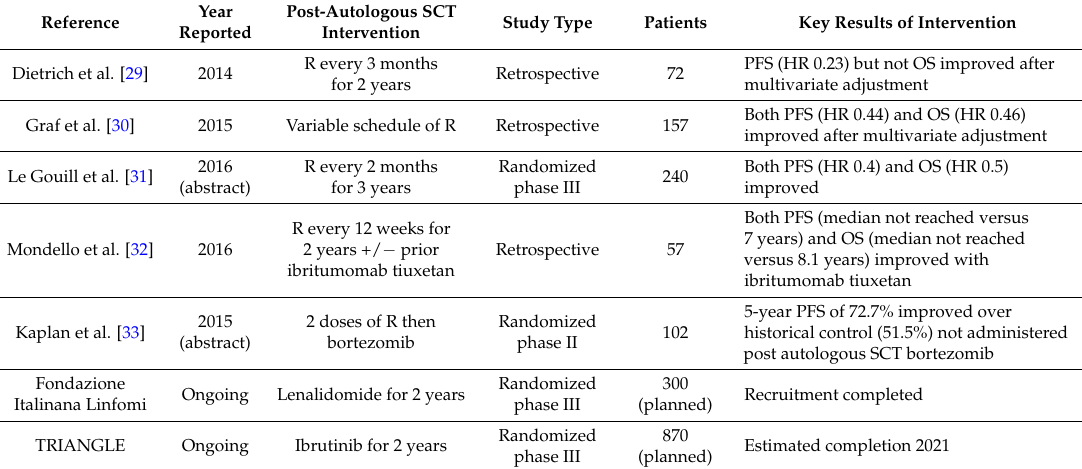
Table 1. Selected studies evaluating maintenance therapy after autologous stem cell transplantation for mantle cell